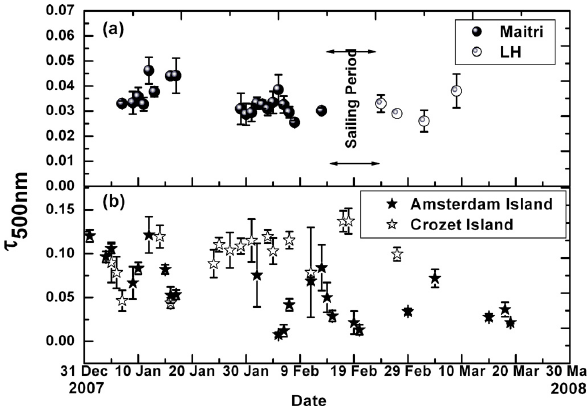
Fig. 4. Daily mean aerosol optical depth ( τ) at 500nm for the Maitri and LH in the top panel (a) and those of Amsterdam and Crozet Is- land in bottom panel (b) , where in the top panel, solid and open circles represent Maitri and LH respectively. The vertical line pass- ing through them as standard deviation from the mean value. In the bottom panel the solid stars represent the daily mean AOD over Amsterdam Island and the open stars represent the AOD over Crozet